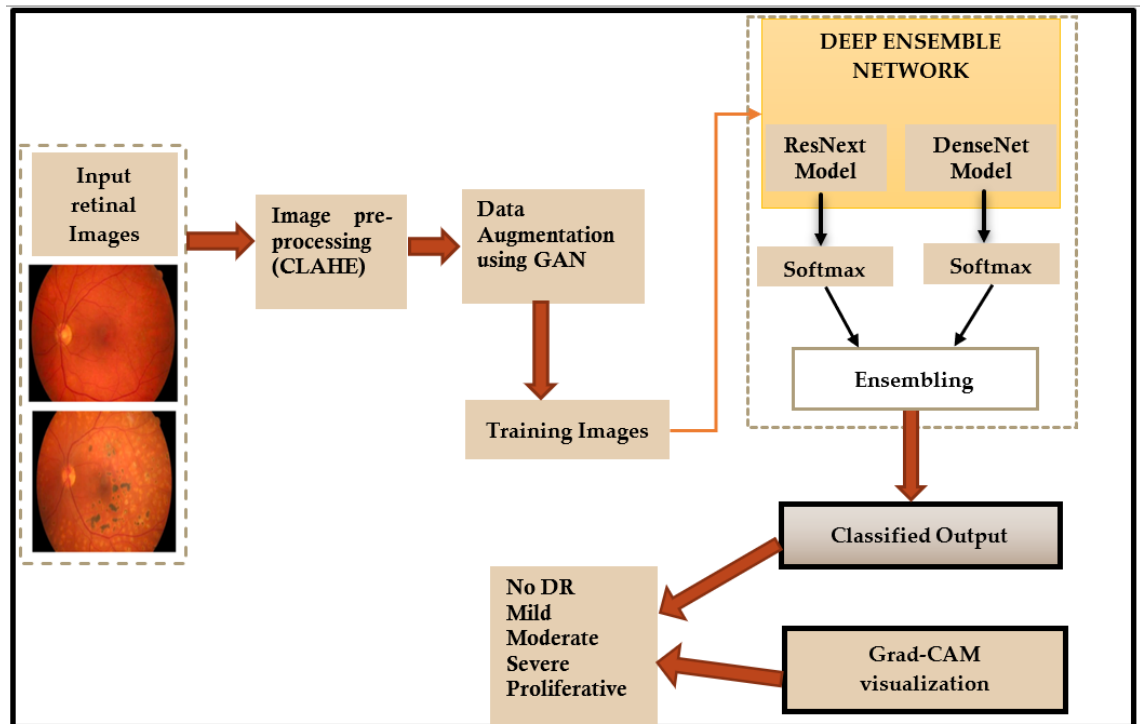
Figure 2. Flowchart of the proposed method.